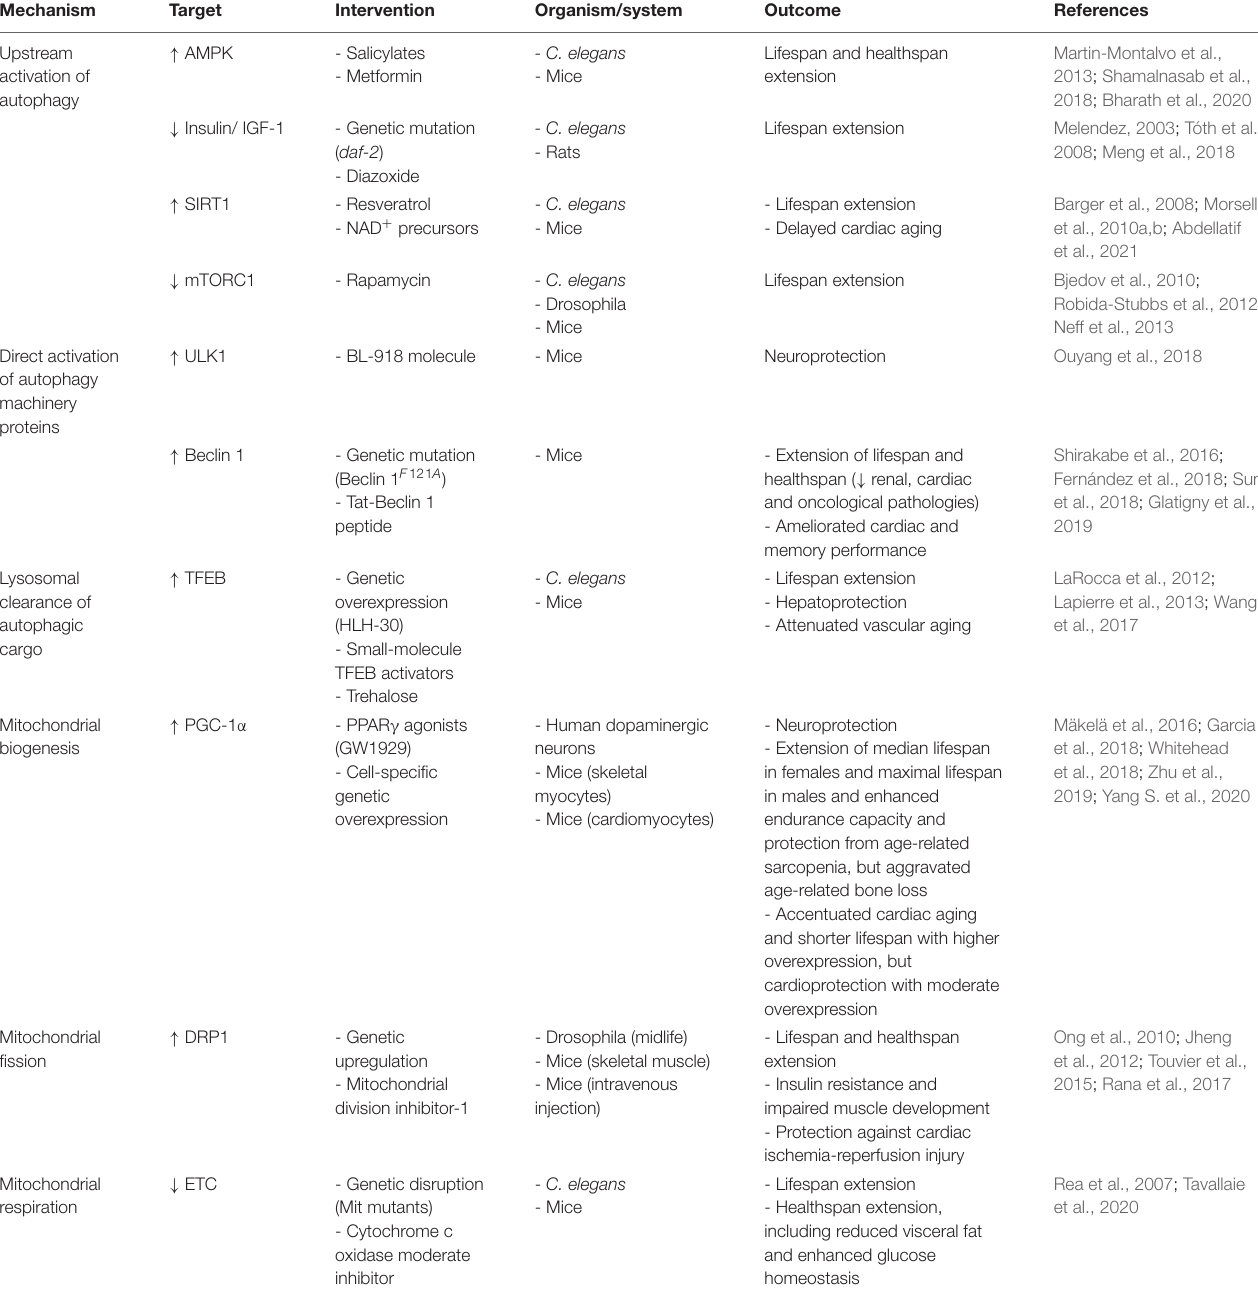
TABLE 1 | Defined molecular targets that delay aging by acting on the mitochondria-proteostasis axis.